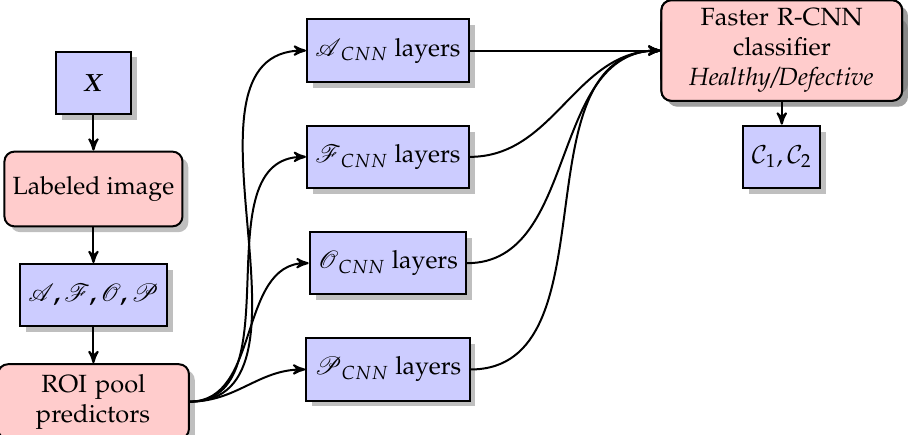
Figure 10. The methodology used in the Faster R-CNN modeling for each disease and defect. The Faster R-CNN approach extracts its own parameters directly from the image as a set of arrays called feature maps, these maps are composed of four main components: a filter bank called kernels, a convolution layer, a non-linearity activation function, and a pooling or subsampling layer. Second, the proposed regions of the network are estimated. The feature maps and the region proposal together are the ROI pool predictors, which are used to classify and detect fruit quality for each layer. The Output is the class raspberry healthy ( C 1 ) or the class raspberry defective ( C 2